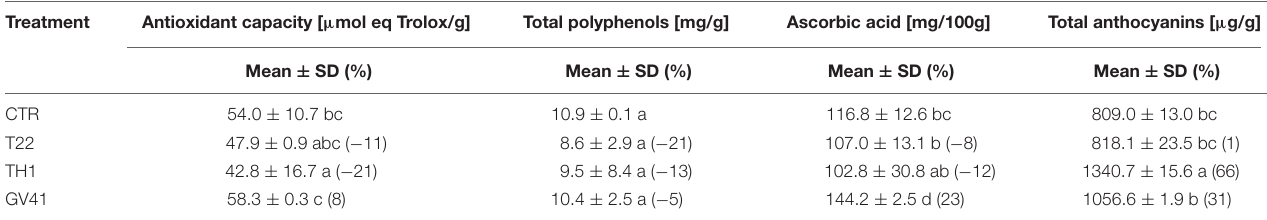
TABLE 2 | Effects of the application of different Trichoderma strains (T22, TH1, and GV41) on the antioxidant properties of strawberry fruits.